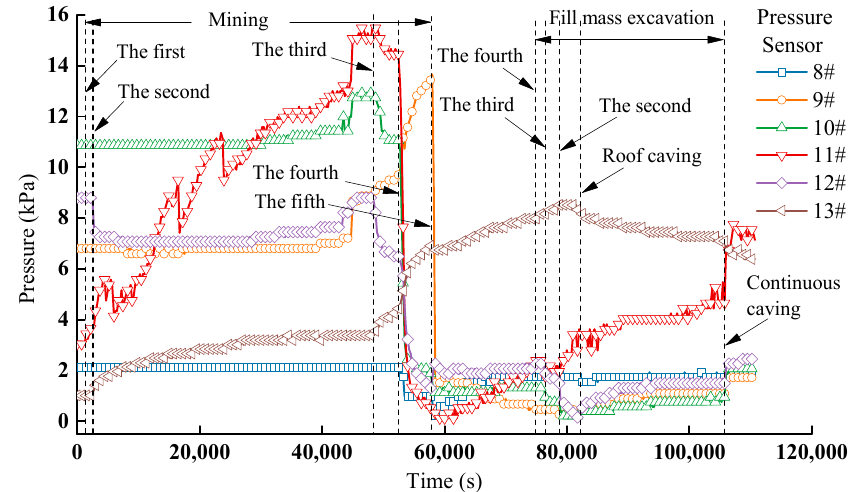
Figure 10. Variation of 8#–13# pressure sensor stress in overlying strata.